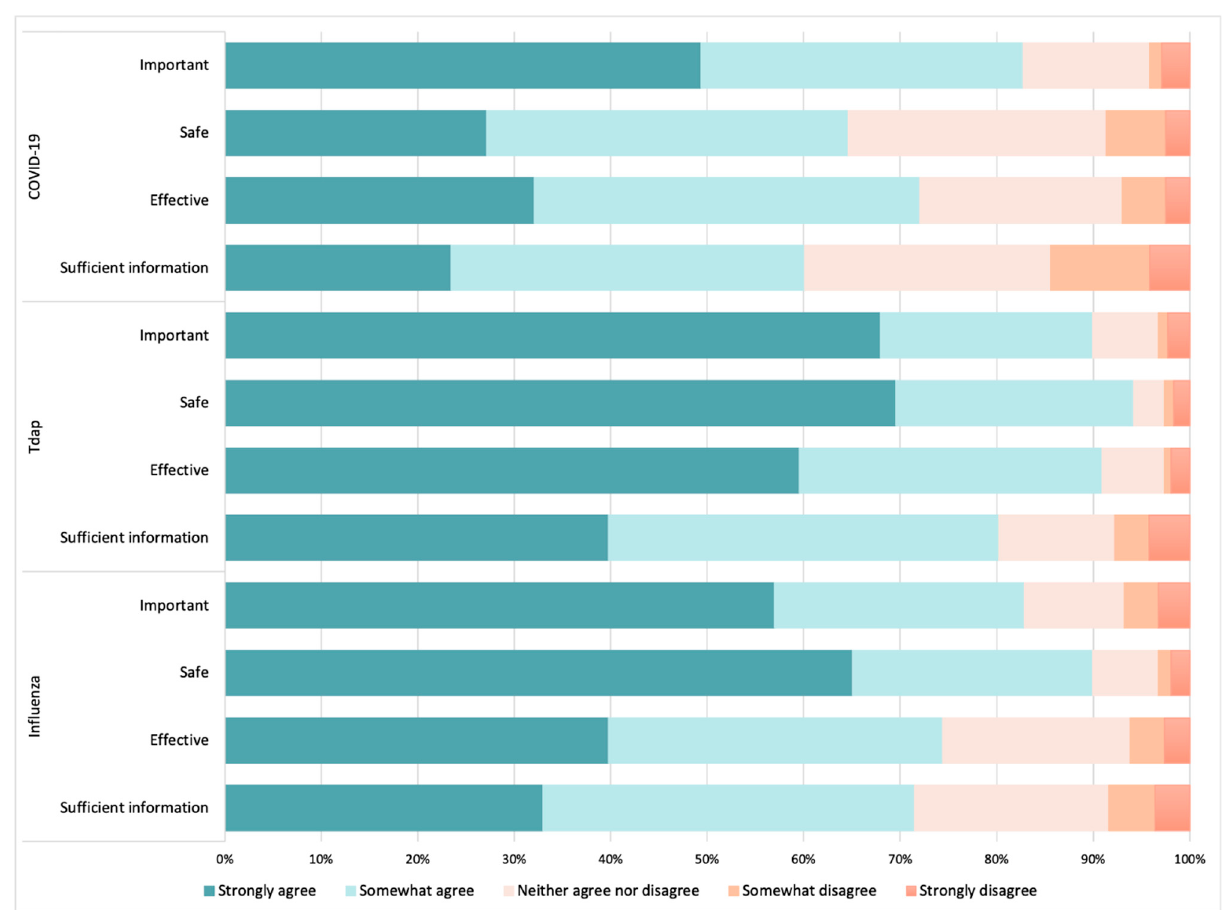
Figure 5. Views and perceptions of HCWs towards COVID-19 vaccination in pregnancy as well as other maternal vaccinations. The data regarding the COVID-19 vaccine above only include data collected after the guidelines for this vaccine for pregnant women came into practice in Spain after July 2021. N COVID-19 = 196; N Tdap = 302; N Influenza = 302.